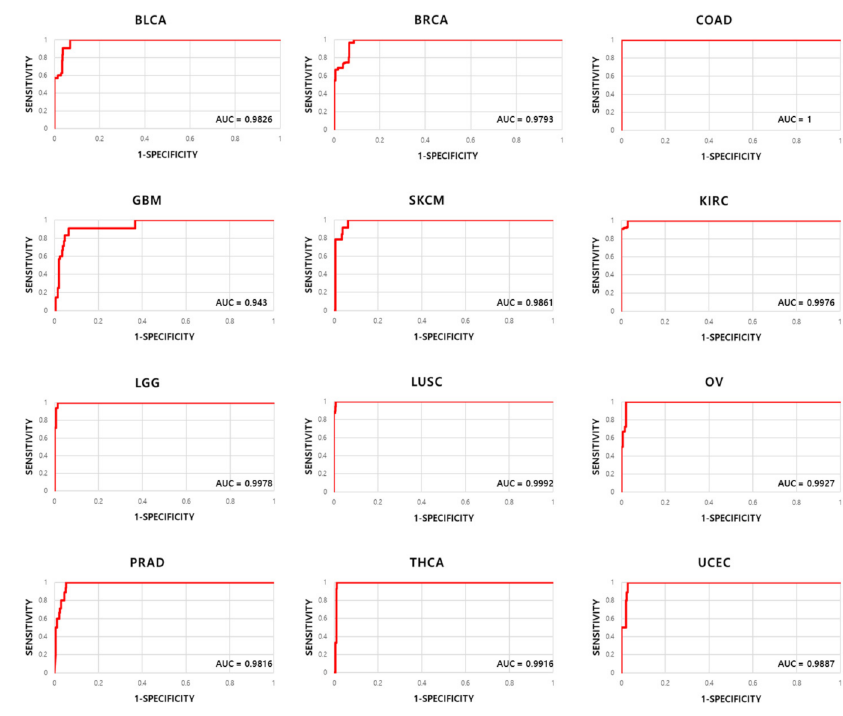
Figure 4. ROC curves of 12 cancers.